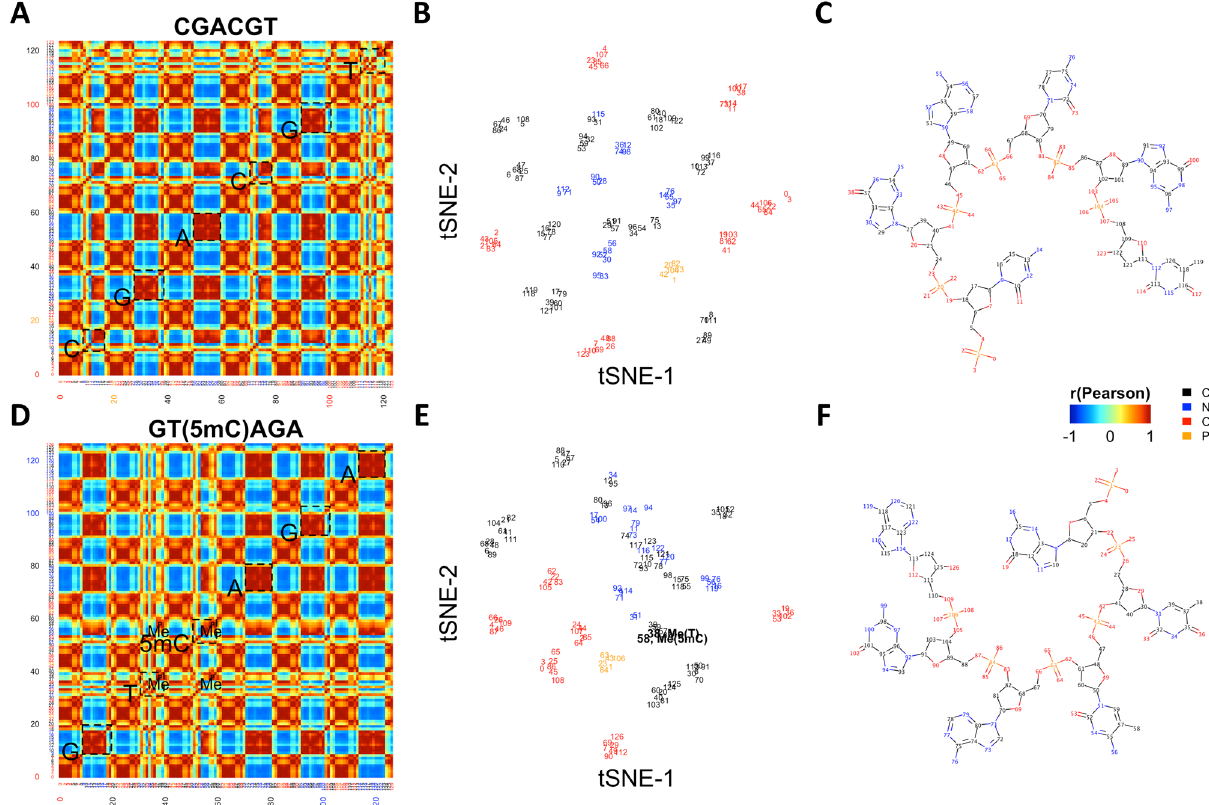
Fig. 2 Visualizing the encoding of chemical structures. A – C Atom similarity matrix, tSNE visualization, and chemical structure of the example canonical DNA 6mer CGACGT. In A , B , atoms were numbered and colored based on the chemical structure in ( C ). Carbon, nitrogen, oxygen, and phosphorus were colored as black, blue, red, and orange, respectively. Speci fi cally, in A , nucleobases were highlighted by dashed boxes. D – F Atom similarity matrix, tSNE visualization, and chemical structure of the example 5mC-containing DNA 6mer GT(5mC)AGA. In D , E , atoms were numbered and colored based on the chemical structure in ( F ). Carbon, nitrogen, oxygen, and phosphorus were colored as black, blue, red, and orange, respectively. Speci fi cally, in D , E , methyl group carbon atoms (#38 in T and #58 in 5mC) were